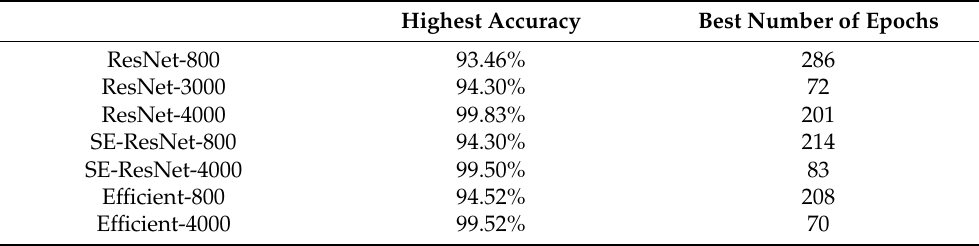
Figure 13. Number of epochs when the model result reached target accuracy. Table 2. Highest recognition accuracy of each model and the corresponding number of